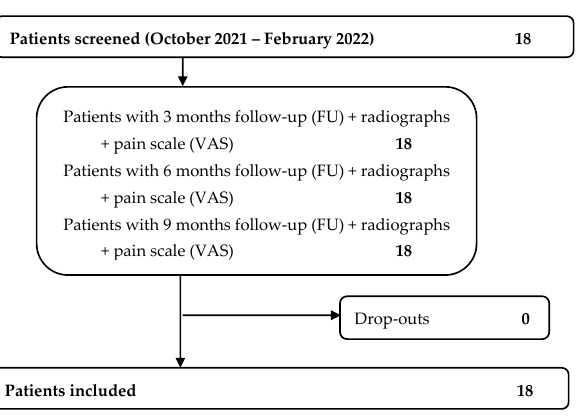
Figure 1. Patients’ flowchart.